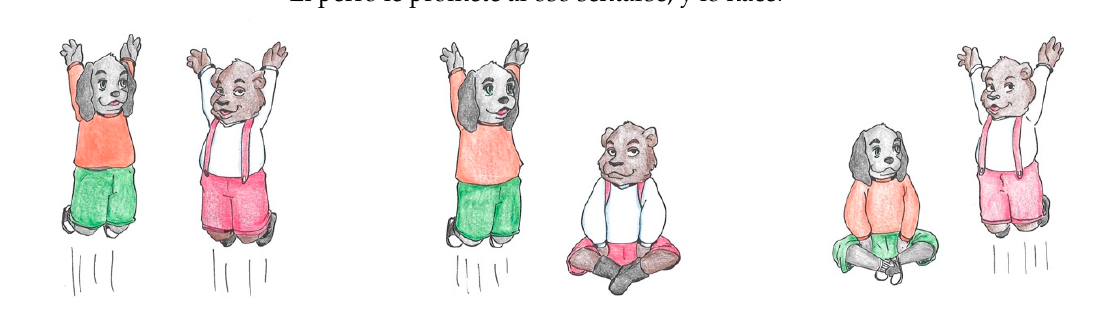
Figure A26. Filler stimulus 1.